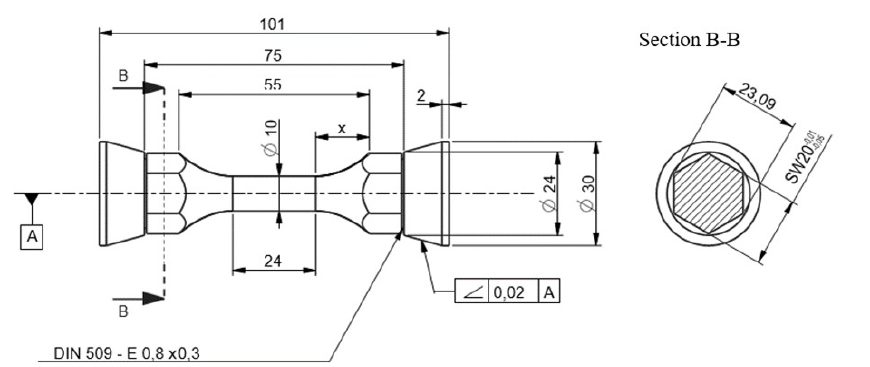
Figure 1. Dimensions of samples.